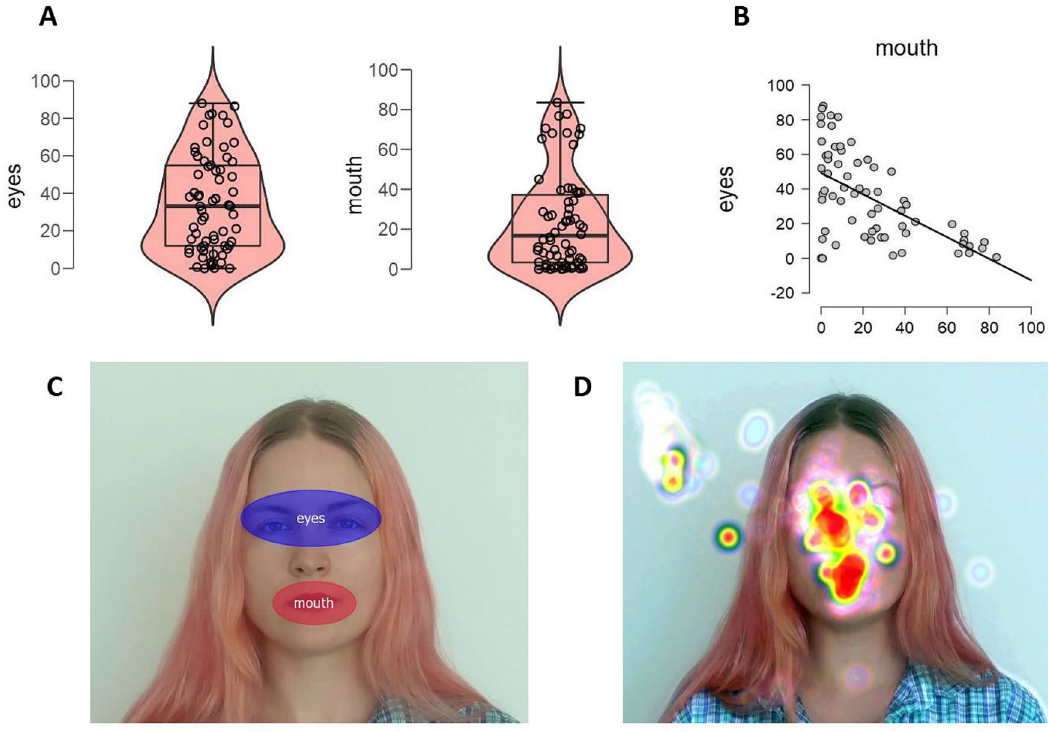
Figure 4. Experiment 1. ( A ) Violin plots of % Dwell Time on the AOI of eyes and mouth. ( B ) Scatterplot of % dwell time in the AOIs. ( C ) The AOIs superimposed to the video image. ( D ) Example heatmap while singing a